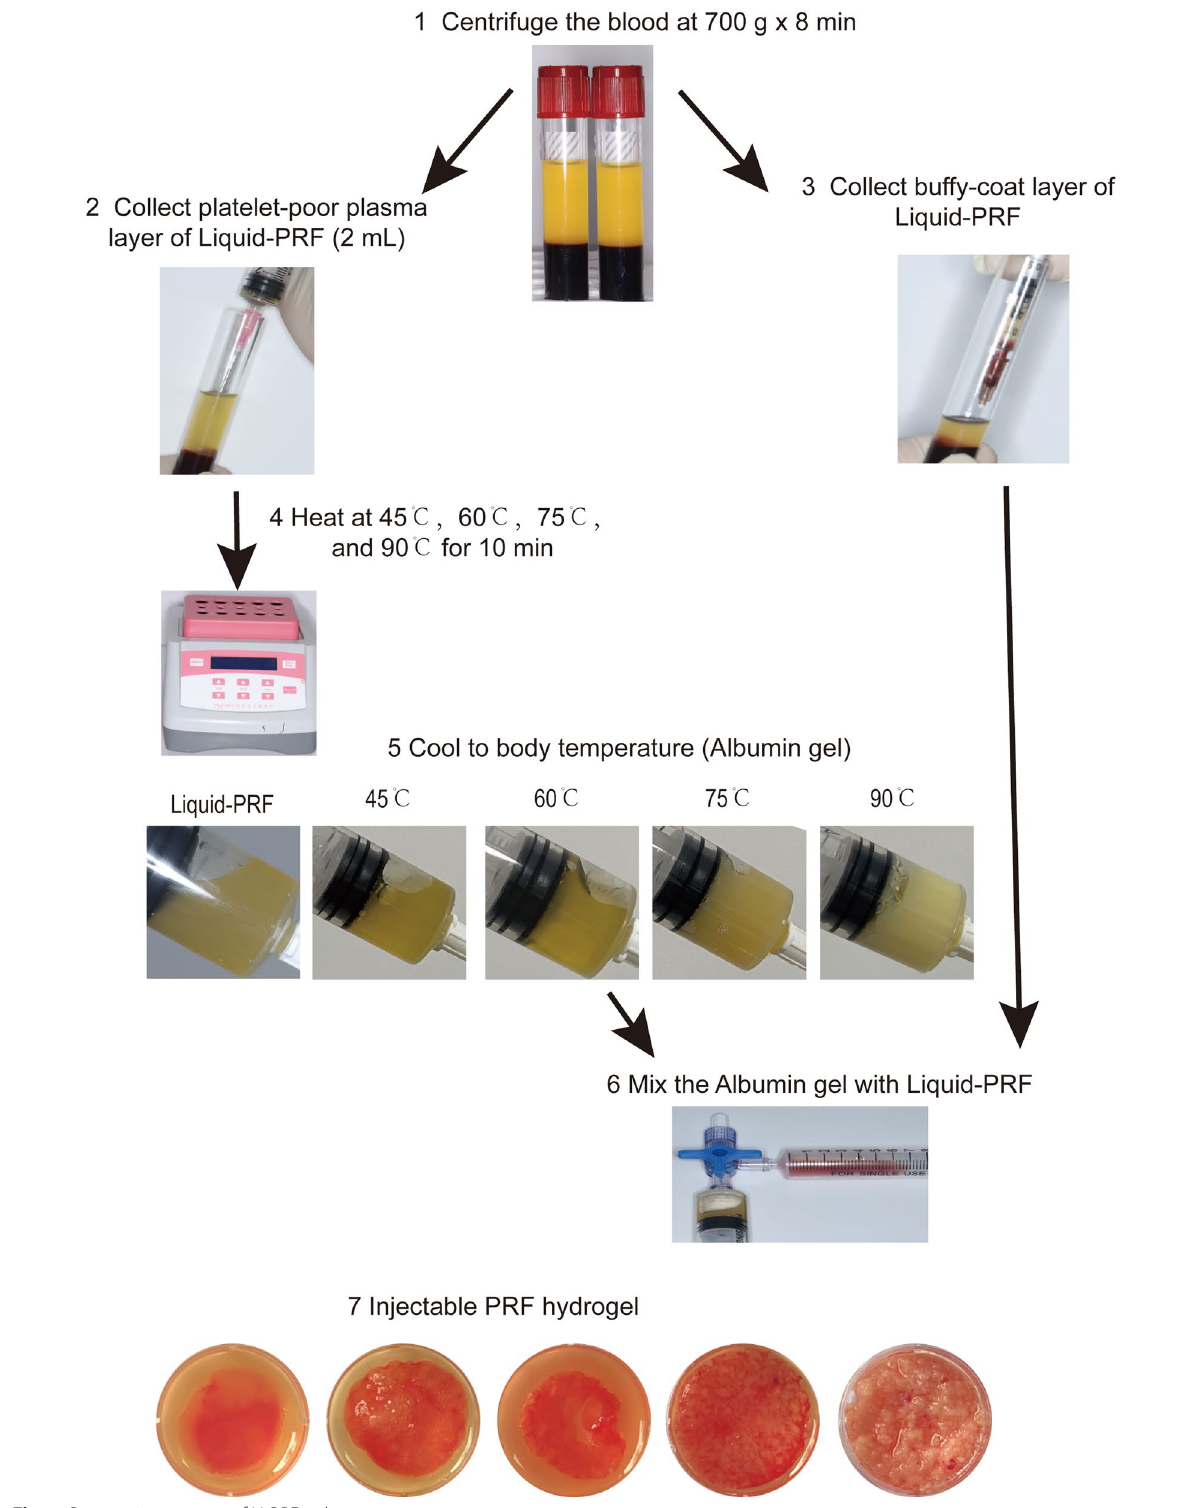
Fig. 1 Preparation process of H-PRF